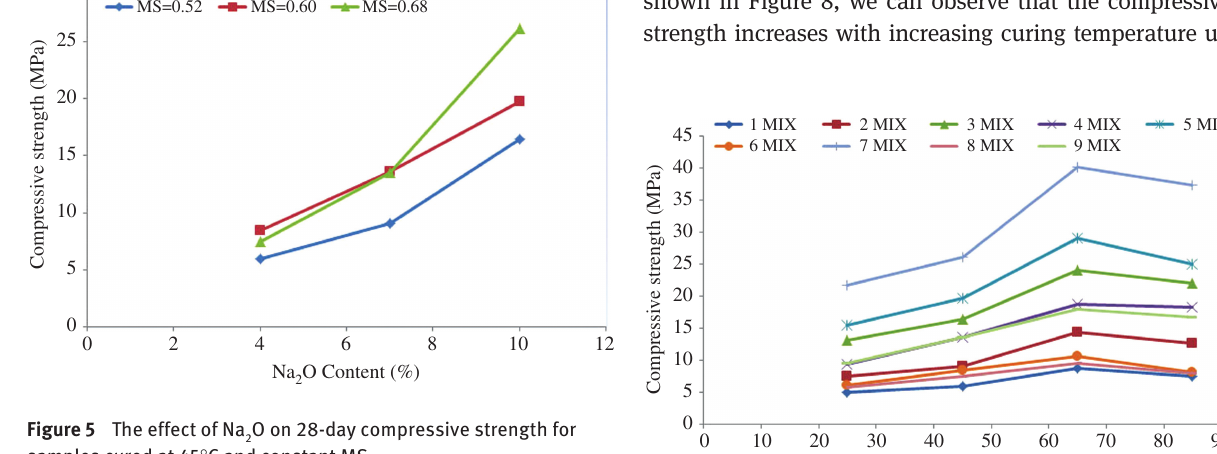
O on 28-day compressive strength for Figure 5 The effect of Na 2 samples cured at 45 ° C and constant MS.